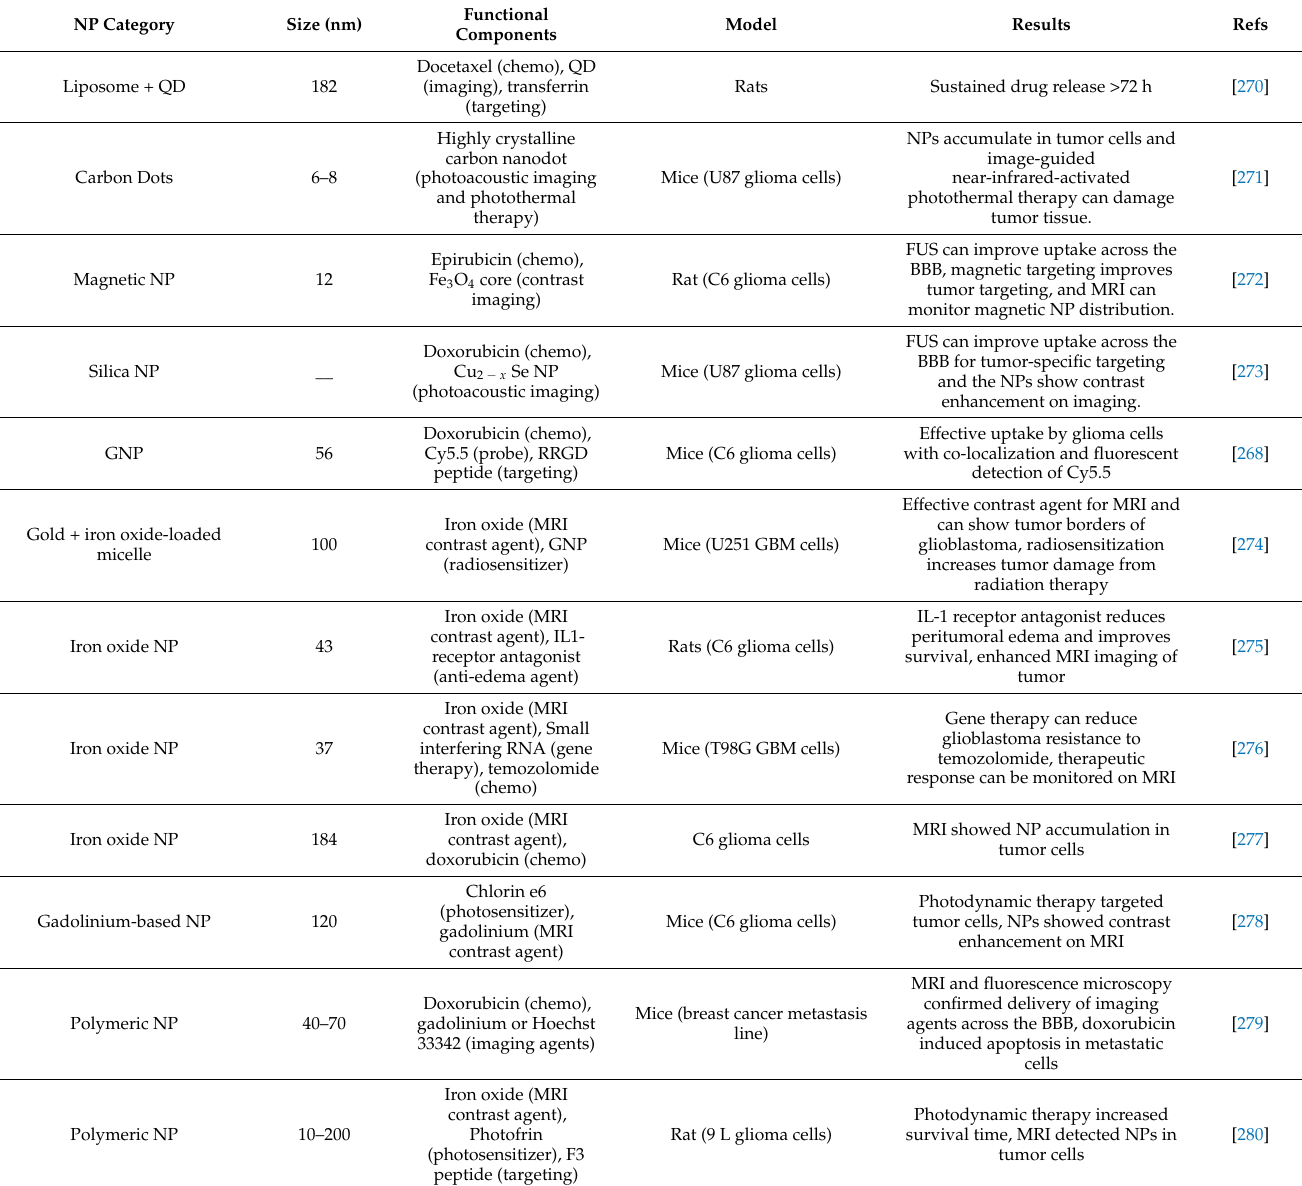
Table 2. Studies on theranostic NPs, investigated for brain cancer, which combine a therapeutic anti-cancer effect with tumor